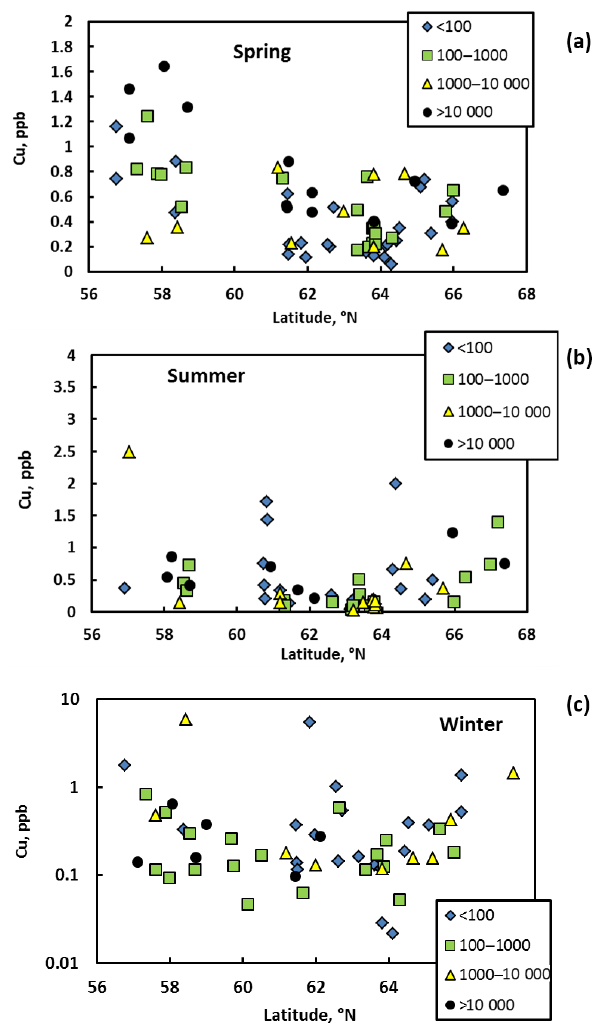
Figure 5. Variation in Cu concentration with latitude during spring (a) , summer (b) and winter (c) for watersheds of different size. The symbols are the same as in Fig.